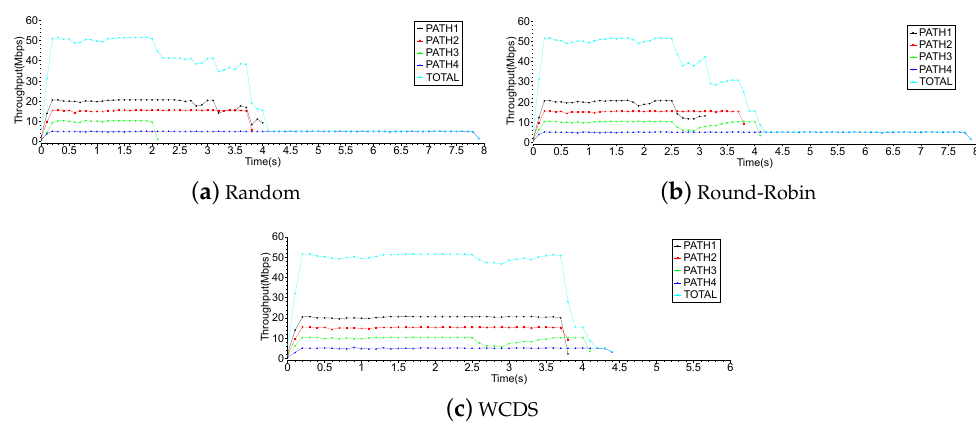
Figure 8. Throughput under Different Scheduling Strategies. ( a ) The variation trends of the through- put under the Random strategy. ( b ) The variation trends of the throughput under the Round-Robin strategy. ( c ) The variation trends of the throughput under the WCDS